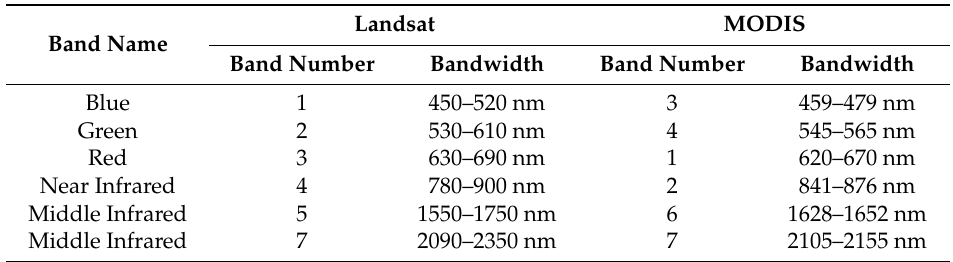
Table 1. Landsat Enhanced Thematic Mapper Plus (ETM+) and Moderate Resolution Imaging Spectroradiometer (MODIS)